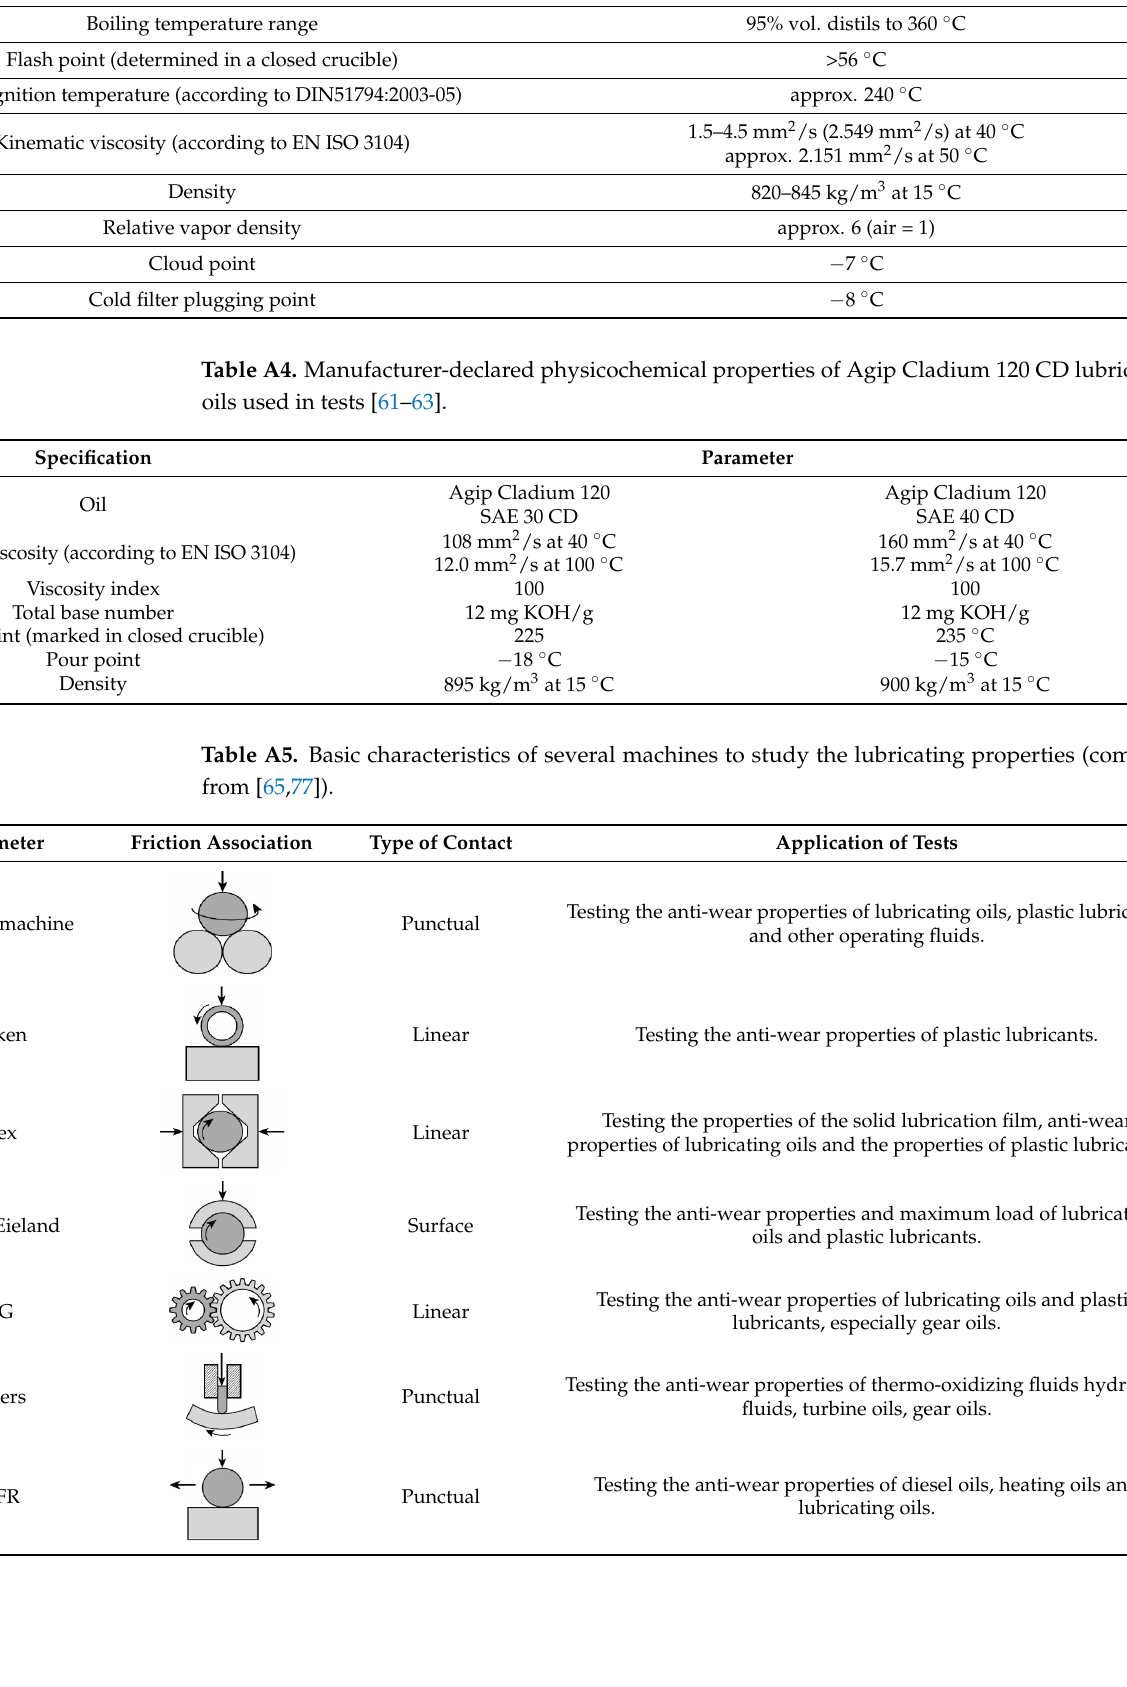
Table A3. Properties of Orlen Efecta Diesel Bio as declared by the manufacturer [60].